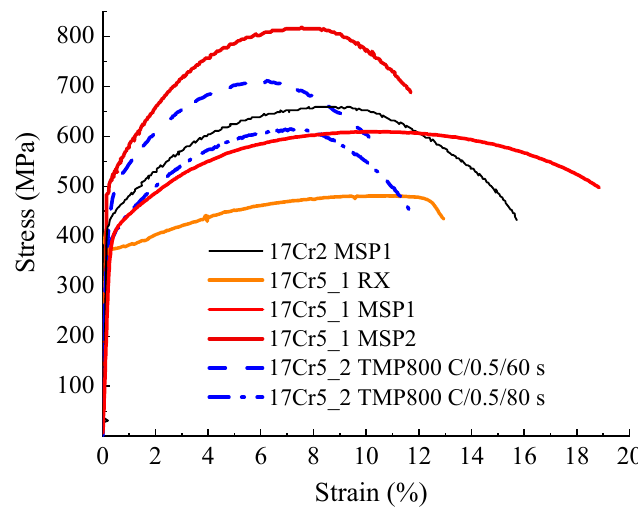
Figure 3. Ambient-temperature stress–strain curves of MSP and TMP 17Cr5 alloys in comparison to the base 17Cr2 alloy in the MSP state.